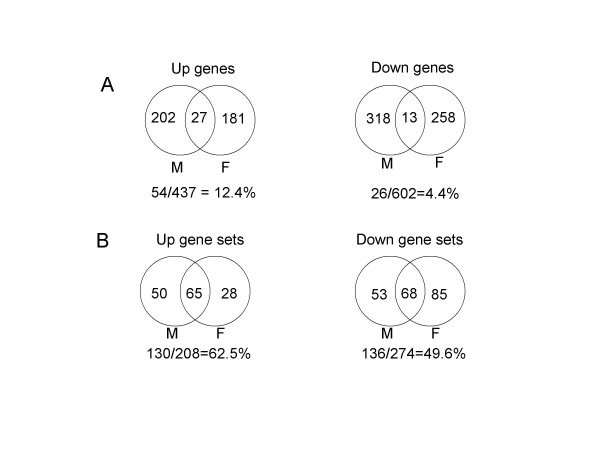
Comparison of different microarray data sets at gene set level shows better congruence than comparison at gene level. A. Comparison of two different microarray data sets at gene level. Two microarray data sets, GDS 287 (Muscle function and aging-Male) and GDS 472 (Muscle function and aging-Female) were analyzed, significantly changed genes (|fold change| > 1.5 and t-test p < 0.05) from each data set were selected, and the percentage of common gene lists for both data sets was calculated. B. Comparison at gene set level. We first performed PAGE on the two microarray data sets, selected significant gene sets (p < 0.05), and calculated percentage of common gene sets for both data sets.